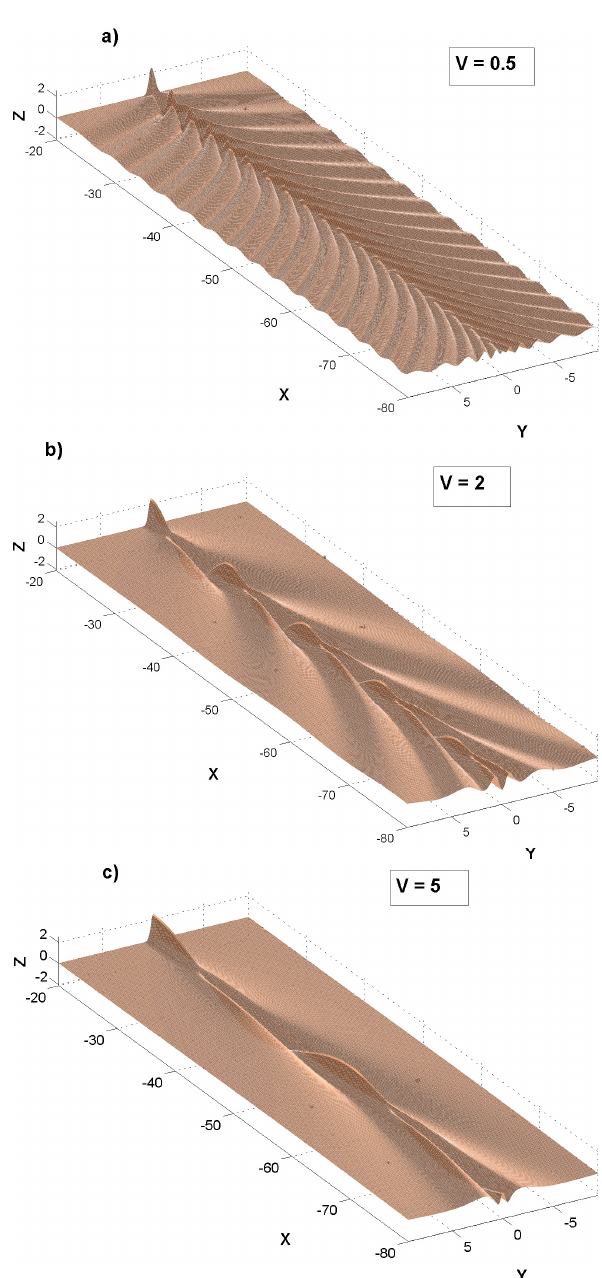
Fig. 11. The “kink”-like disturbances of the current sheet produced by the moving source for different normalized